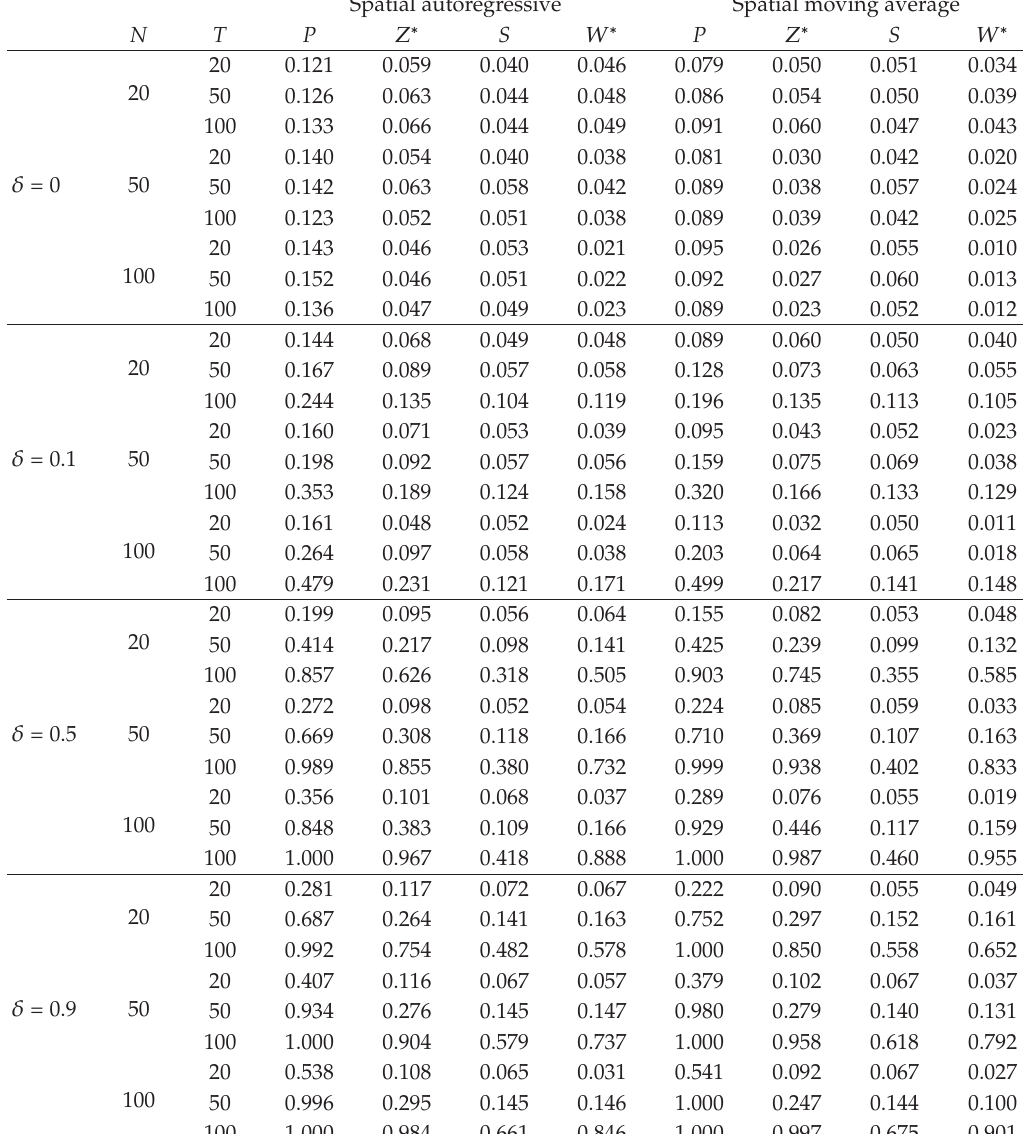
Table 4: Size and power of panel unit root tests: intercept only, spatial dependence. Spatial